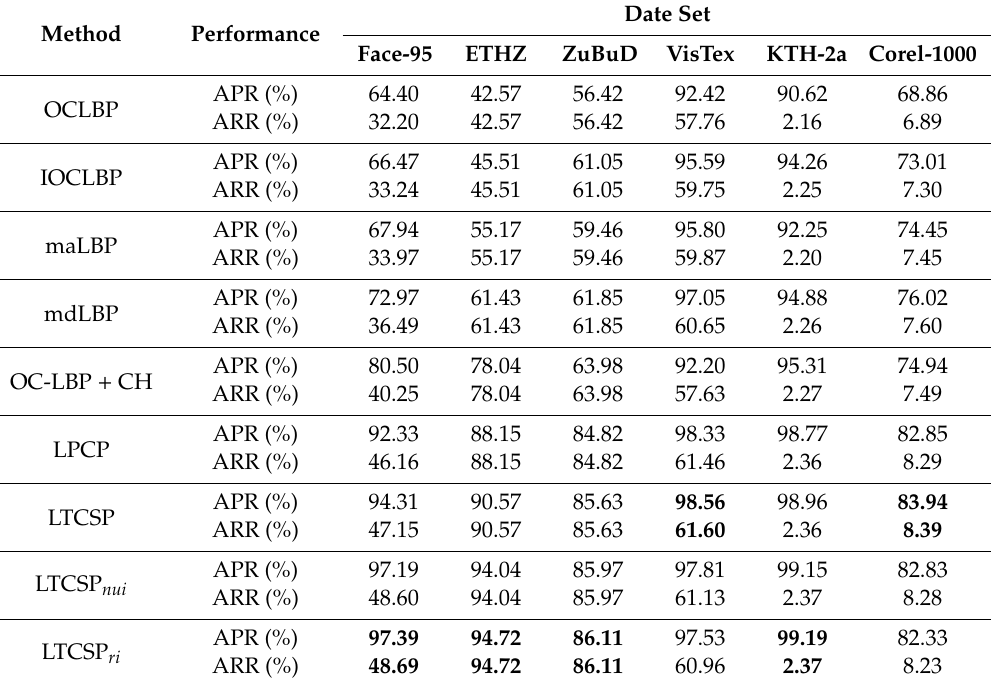
Table 5. The evaluations of APR and ARR rates obtained by the proposed descriptors and six state-of-the-art color LBP descriptors on six